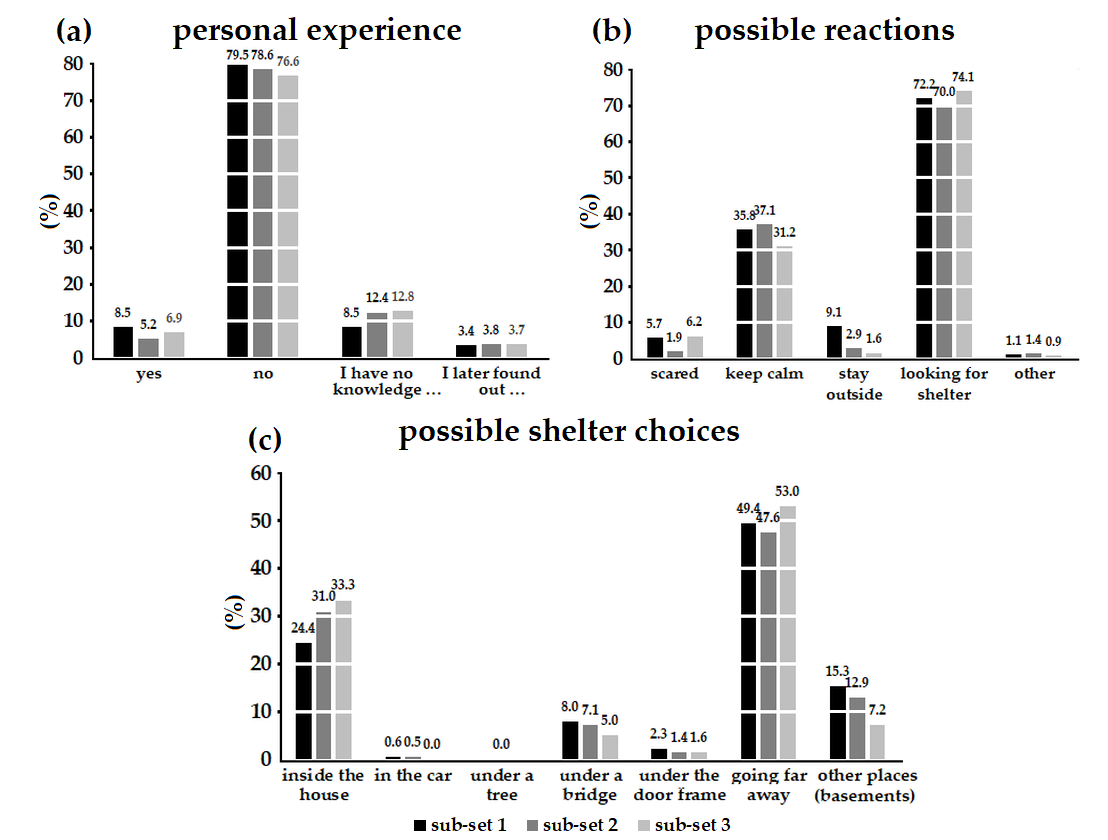
Figure 8. The distribution of results in sub-sets for questions Q10 to Q12 regarding: the respondents’ personal experience with tornadoes ( a ), their possible reactions ( b ) and their shelter choices in the case of tornado experience ( c ).